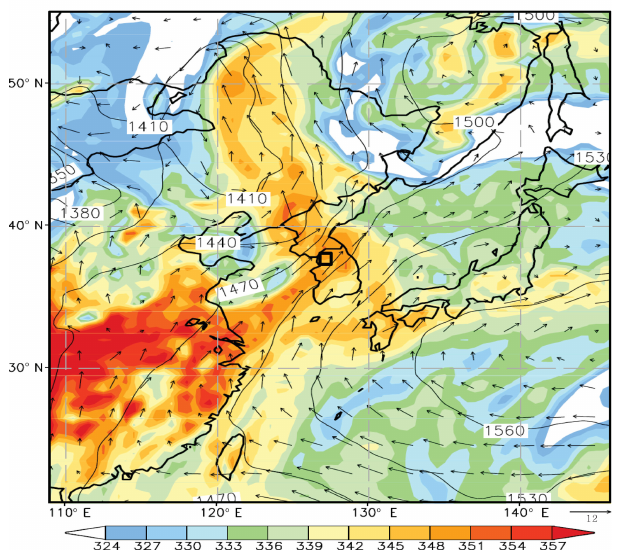
Figure 1. The 850hPa wind (ms − 1 , arrows), geopotential height (m, contours), and equivalent potential temperature (K, shaded) at 21:00LST on 26 July 2011 over northeastern Asia. The rectangle on the Korean Peninsula marks Domain 3, which is explained in Sect. 3.2 and shown in Fig. 2.